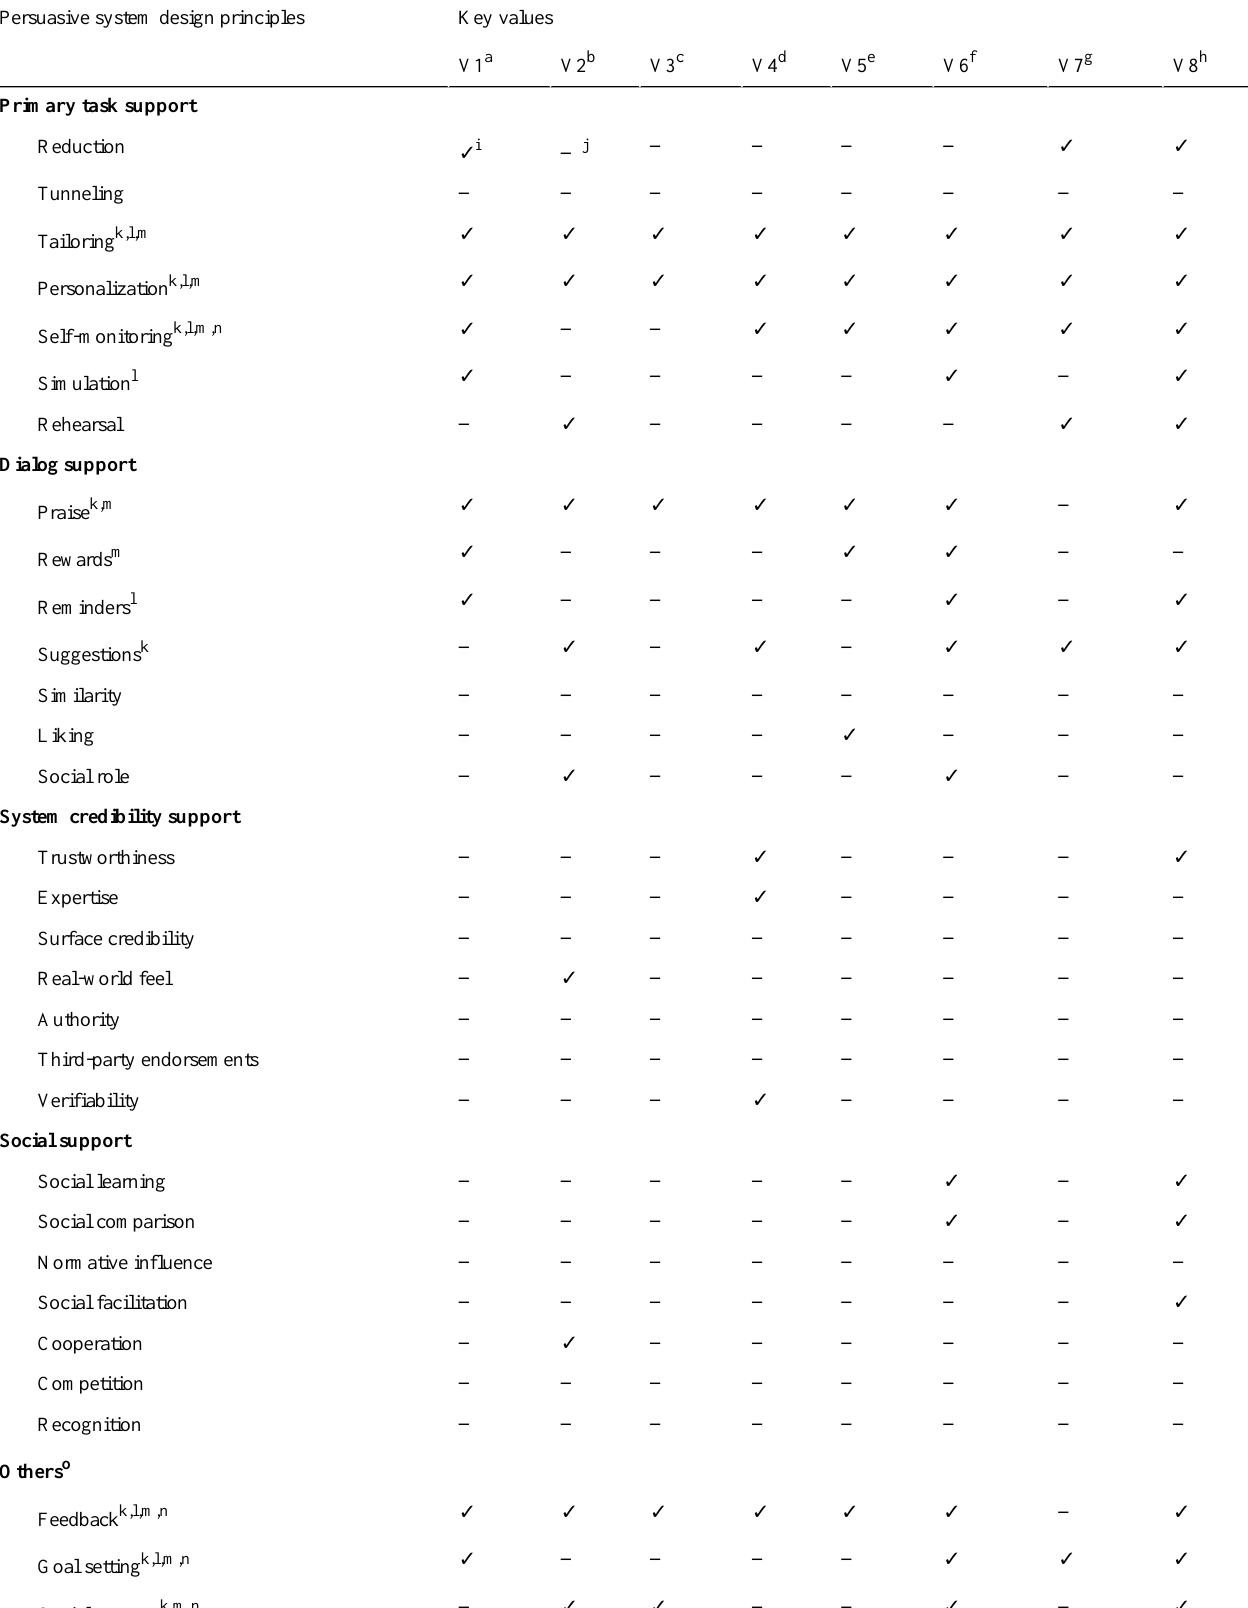
Table 4. Identified persuasive system design principles supporting end user values.